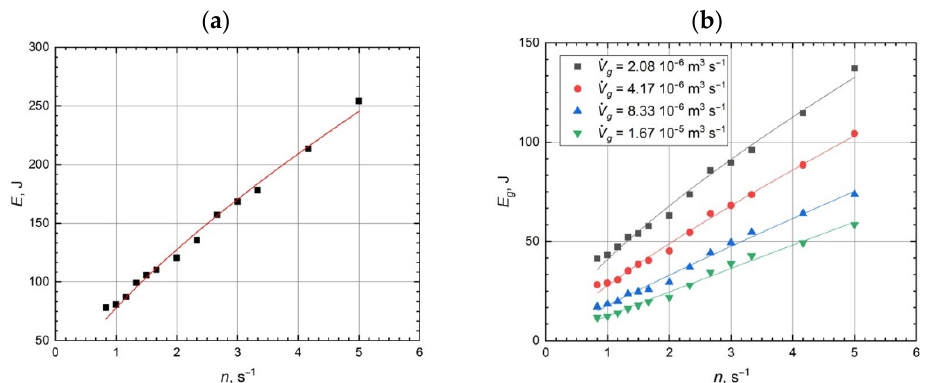
Figure 2. Mixing energy versus impeller speed: ( a ) ungassed conditions, ( b ) gassed conditions.